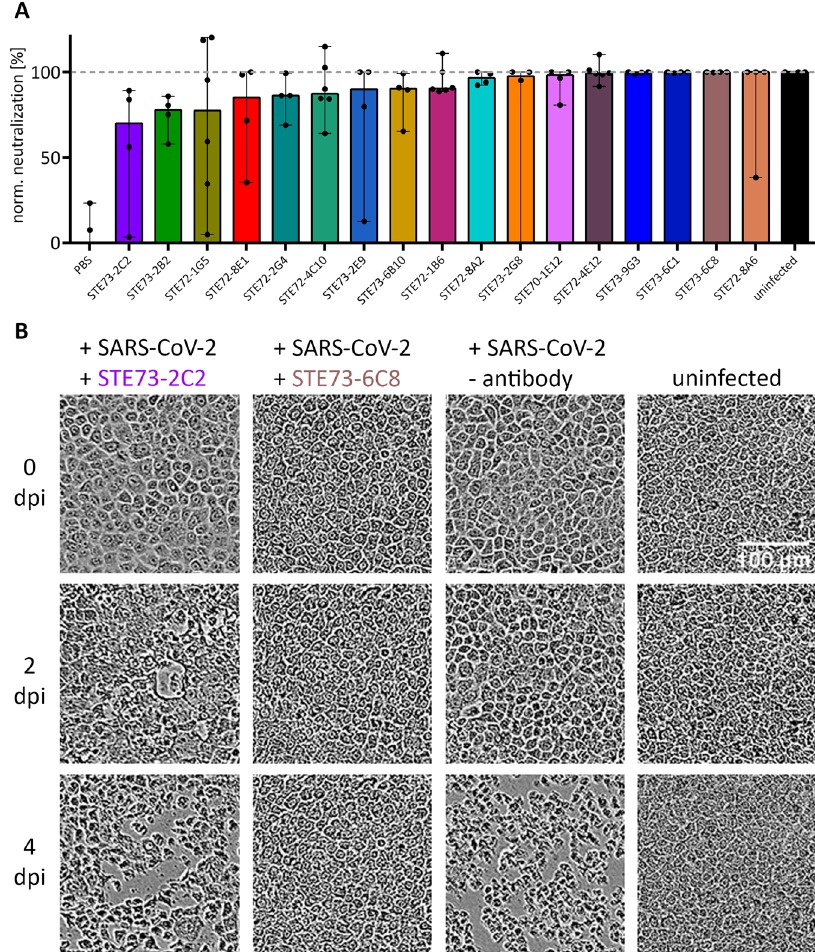
Fig. 4 SARS-CoV-2 neutralization in the scFv-Fc format. Neutralization analysis using 250 pfu of SARS-CoV-2 in a CPE-based neutralization assay. A Cell monolayer occupancy at 4 days post infection in the absence of neutralizing antibodies was compared to uninfected control cells and median values were normalized as 0 and 100% occupancy, respectively. Histograms indicate medians of normalized monolayer occupancy in a neutralization assay using 1 µ g/ mL (~10 nM) antibody for each of the 17 tested antibodies. Data show the median from 4 or 6 replicates, the black dots indicate monolayer occupancy in individual assays, and the range is given for the maximum and minimum measurements. B Representative phase-contrast microscopic pictures of uninfected cells, cells infected in the absence of antibodies, in the presence of a poorly neutralizing scFv-Fc (STE73-2C2), or of a highly neutralizing scFv-Fc